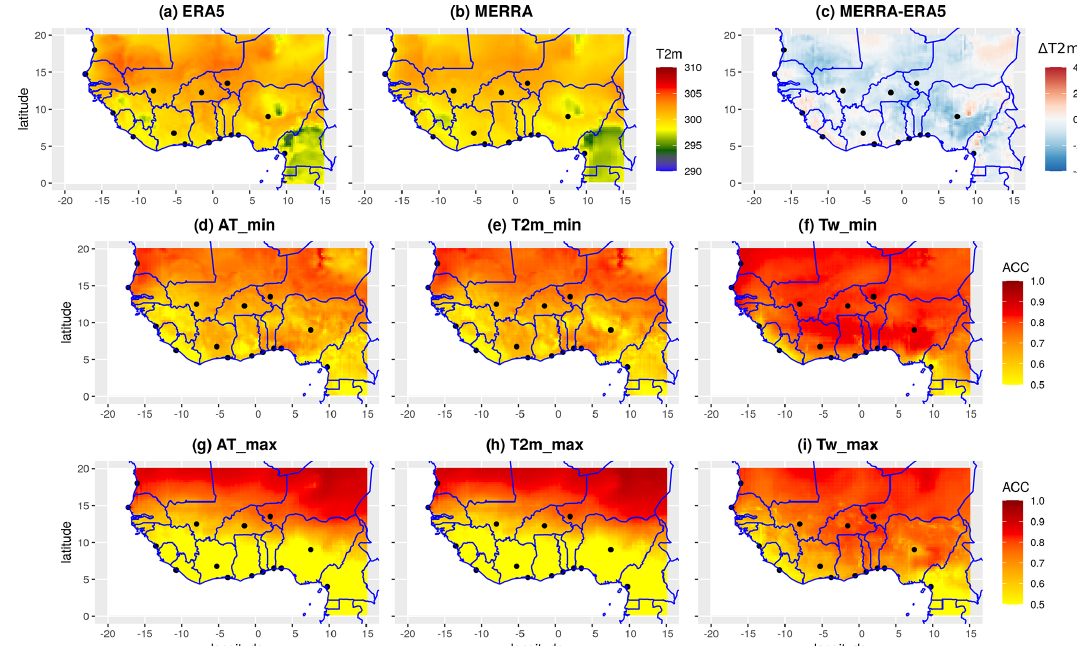
Figure 3. Assessment of the evolution of some atmospheric variables in the reanalyses data: (a–b) climatology state of T 2m over 1993–2020 for ERA5 and MERRA respectively; (c) climatological bias between MERRA and ERA5 using ERA5 as reference ( (cid:49)T 2m ); (d–f) / (g– i) anomaly of correlation between MERRA and ERA5 respectively for min/max values using AT, T 2m and T w variables. The x and y axes represent the longitude and latitude in degrees respectively. The colour bars show the temperature ( T 2m ) in kelvins and the values of the anomaly of temperature (ACC) respectively. The black points in the map represent the cities of interest analysed in this work (see the “Region of interest” section for more details); this applies for all the maps in the